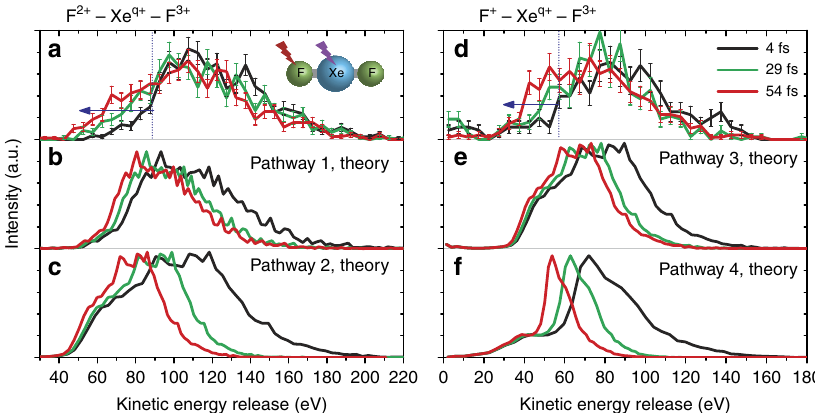
Figure 3 | KER distributions. X-ray pump/X-ray probe KERs of the F 2 þ –Xe q þ –F 3 þ and F þ –Xe q þ –F 3 þ break-up channels, averaging over all Xe charge states (q) observed in the experiment, h q i ¼ þ 3 : 9. The time delays are 4fs (black line), 29fs (green line) and 54fs (red line). A time dependence is observed for a pump pulse that excites the Xe site at 690eV and a probe pulse that excites strong 1 s - 2 p resonances near 683eV of the transient states leading to F þ and F 2 þ ions. ( a , d ) Experimental results: the time dependence reveals hetero-site pump-probe events. Pump and probe pulses have B 10-fs FWHM with B 5-eV energy widths. ( b , c , e , f ) Theoretical results based on a classical break-up model for the three time delays, following pathways (1), (2), (3) and (4), respectively. The theoretical results only account for pump-probe events and are consistent with the experimental observations in the KER ranges left from the vertical lines. The error bars represent the standard deviation of the